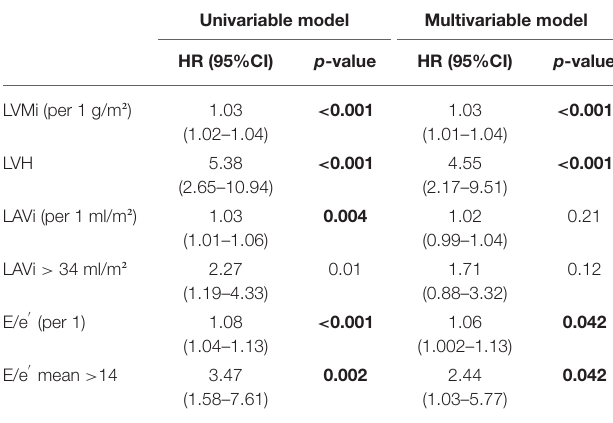
TABLE 3 | Survival analyses for the primary outcome in the RA Porto